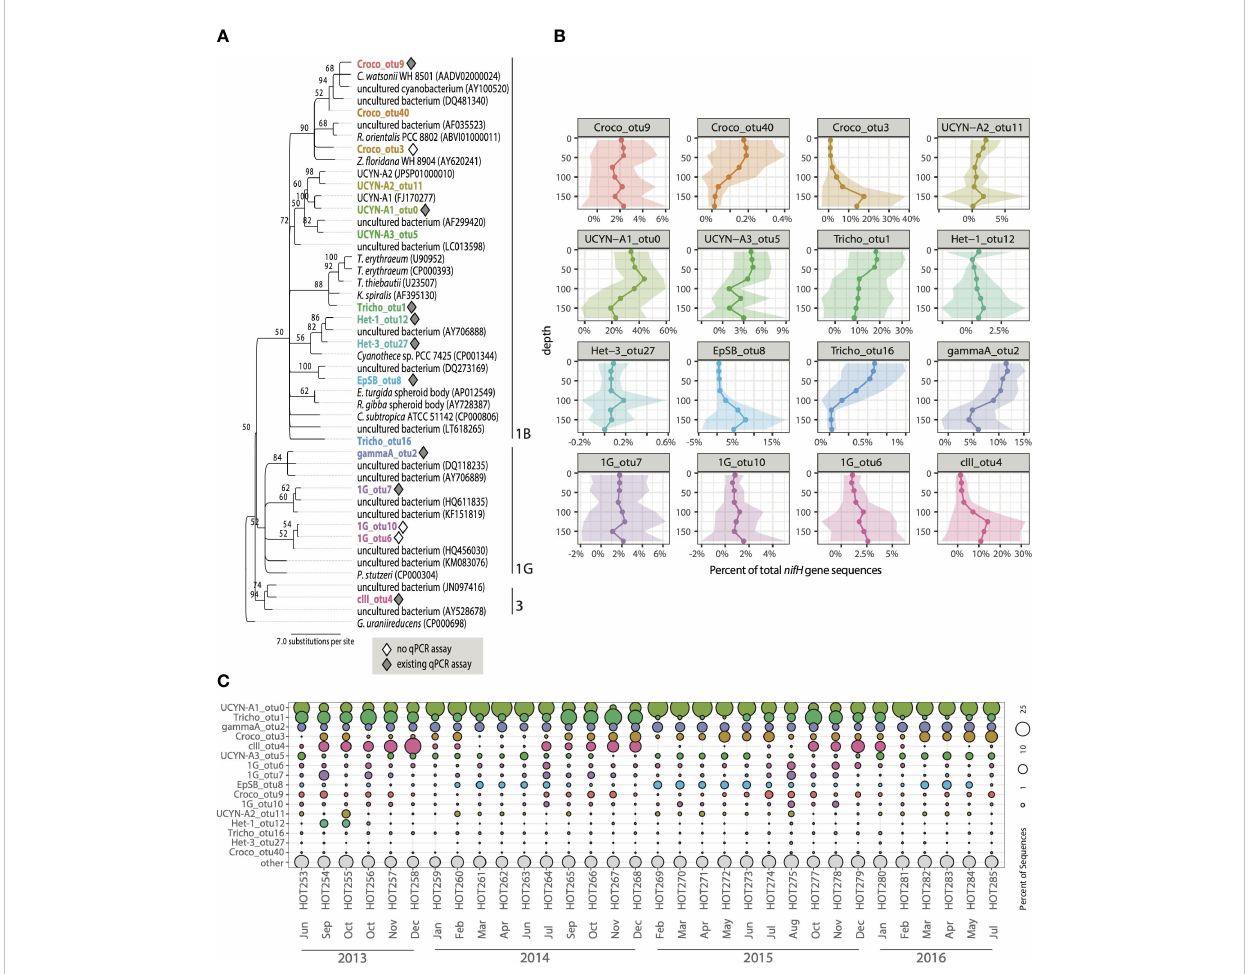
FIGURE 1 Overview of the diversity, depth distributions, and relative abundances of major diazotrophs at Stn. ALOHA. (A) Maximum likelihood (RAxML; Stamatakis, 2014)) tree of partial nifH gene nucleotide sequences (clustered at 97% nt identity) including representative sequences corresponding to the OTUs with high relative abundances, along with reference sequences from closely related organisms. The phylogenetic tree was built based on 341 nifH nucleotide positions and the GTR GAMMA model of nucleotide rate heterogeneity (Yang, 1994) was used to determine branch lengths. The percentage of calculated trees in which sequences clustered together in the bootstrap test (100 replicates) is shown next to the node when greater than 50%. Genbank accession numbers of reference sequences are in parenthesis. OTUs with existing qPCR assays are indicated with grey diamonds and white diamonds indicate OTUs with no known qPCR assays. Cluster designations follow the convention established in Zehr et al. (2003). (B) Depth patterns in the euphotic zone of the selected OTUs are plotted as solid lines representing mean values of relative abundances across the time series with shading representing +/- 1 standard deviation. (C) Relative abundances of select OTUs summed across depths for each cruise. Rows represent diazotroph OTUs, and the size of the bubble scales to relative abundances for each group